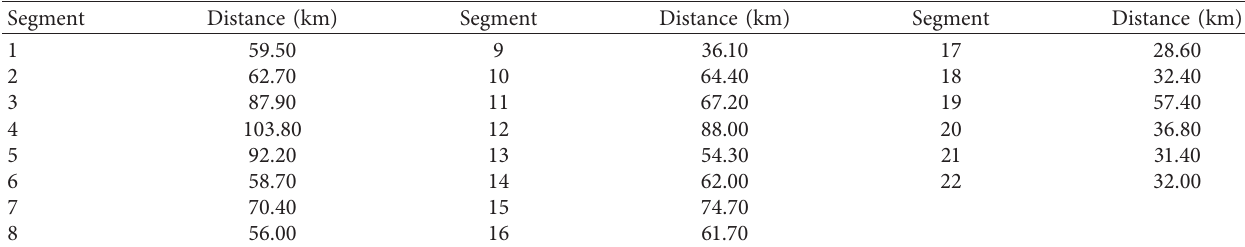
Table 2: The distance in each